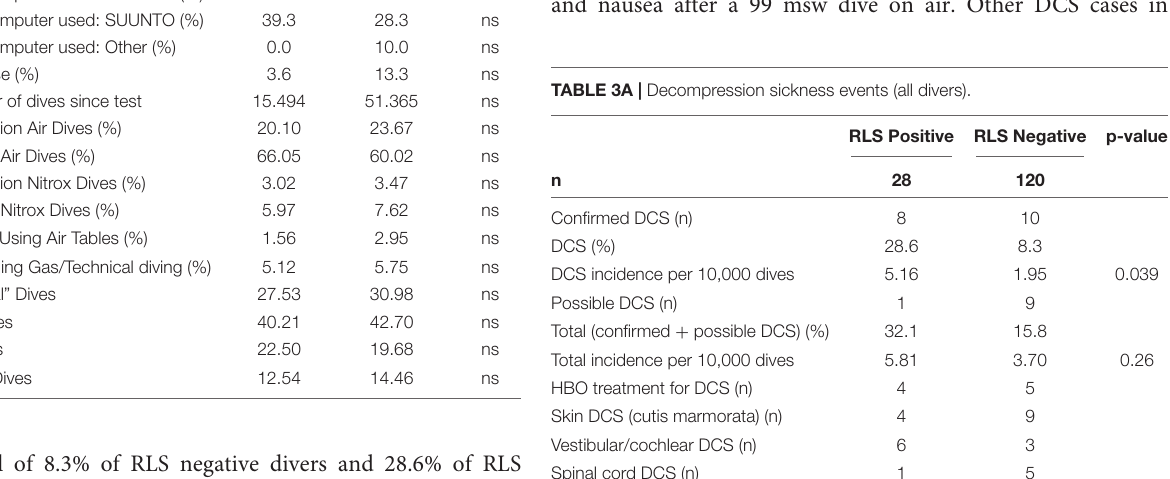
RLS RLS Positive Negative